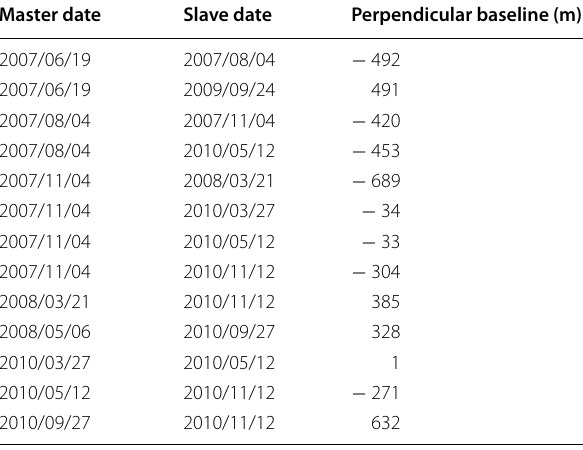
Table 1 Interferometric pairs used for the time-series